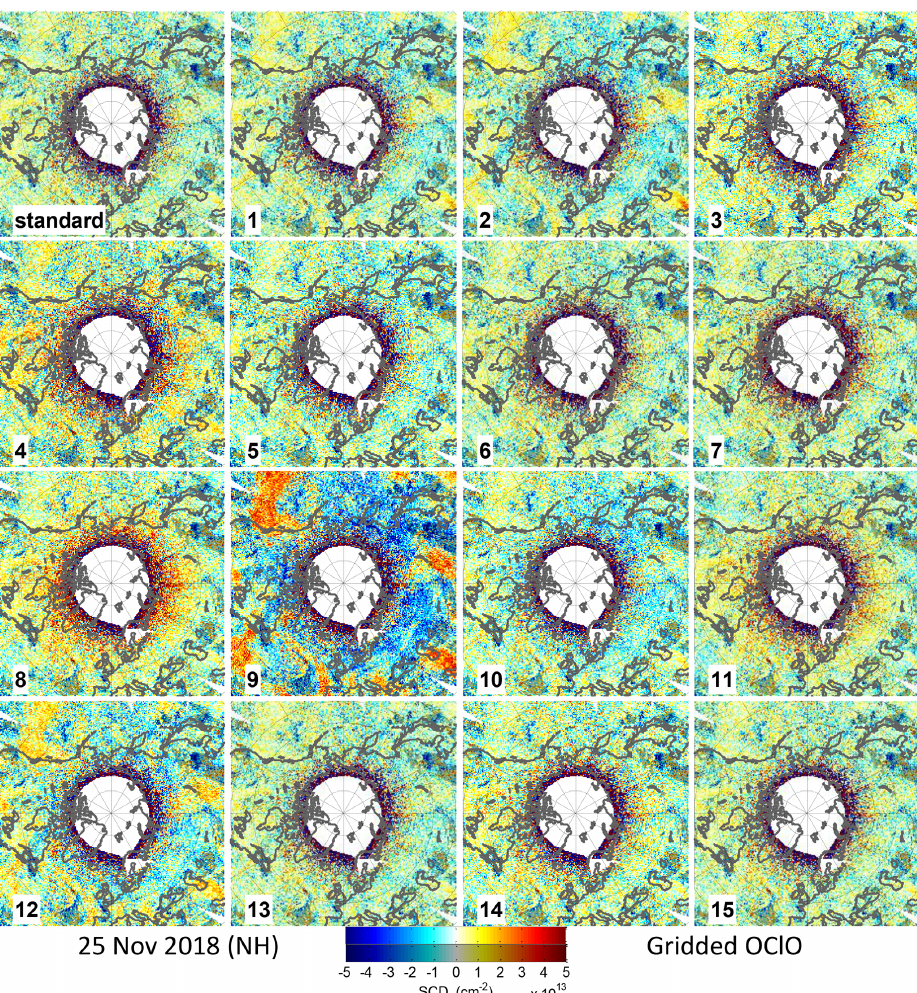
Figure B4. OClO SCDs for 25 November 2018 in the NH binned on a 0 . 2 ◦ × 0 . 2 ◦ grid in an equidistant in latitude coordinate projection. Areas with cloud fractions (CF) below 5% are